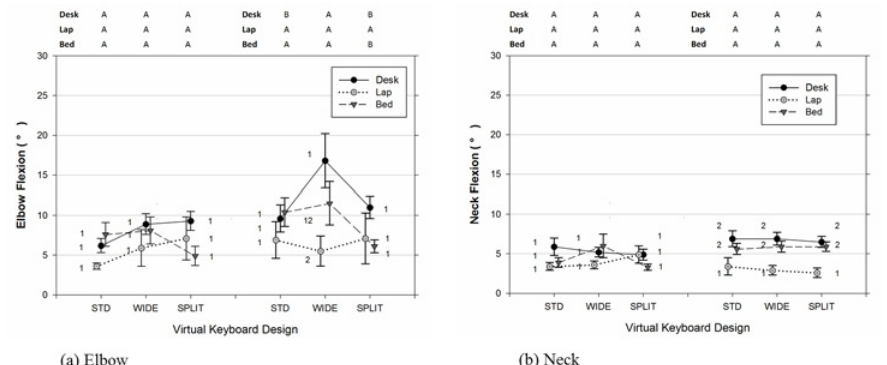
Fig 7. Range of wrist movement (APDF Range) in term of flexion/extension for the (a) elbow and (b) neck varied across different positions of tablet usage and virtual keyboard designs. Error bars represent +/- 1 SE. The conditions observed from the early 10 – 25 min period (left side) and later 55 – 60 min period (right side) are separated accordingly in each sub figure. Conditions with the same number (1, 2, 3) denote groups without significant difference across the usage positions within the same virtual keyboard design. Conditions with the same character (A, B, C) denote groups without significant difference across the keyboard designs within the same usage